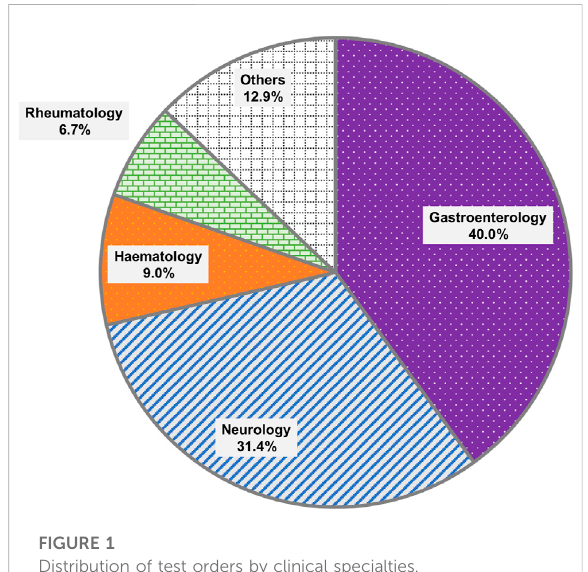
FIGURE 1 Distribution of test orders by clinical